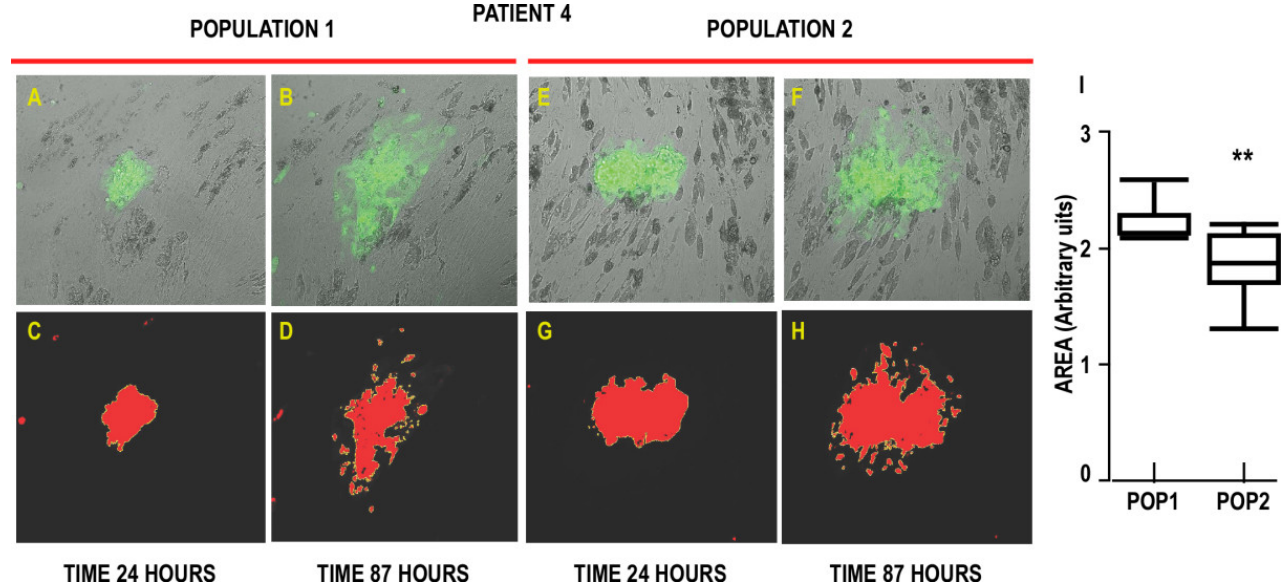
Figure 5. Interactions of the two breast adipose progenitor cell (APC) populations with MCF7 mam- mospheres. Time-lapse analysis of breast cancer mammospheres spreading on Populations 1 ( A – D ) and 2 ( E – H ) was performed on cells differentiated for 21 days. They were incubated for 24 h with MCF7 mammospheres expressing GFP prior to recording for the mammospheres to adhere to the cells. Recording lasted for 63 h and was performed every 20 min, using an inverted AxioObserver-Zeiss microscope equipped with a sCMOS ANDOR Neo camera at 37 °C in a CO2-controlled atmosphere (magnification 10×). The area covered by the mammospheres was analyzed by using IM- AGE J. The red image delineates the area after defining the threshold level to ignore non-specific signals. The increase in mammosphere size was calculated by the ratio of the areas measured at the beginning and at the end of the experiment. ( I ) Box plots of the data are presented for each patient in Supplementary Table S2 (** p < 0.01).